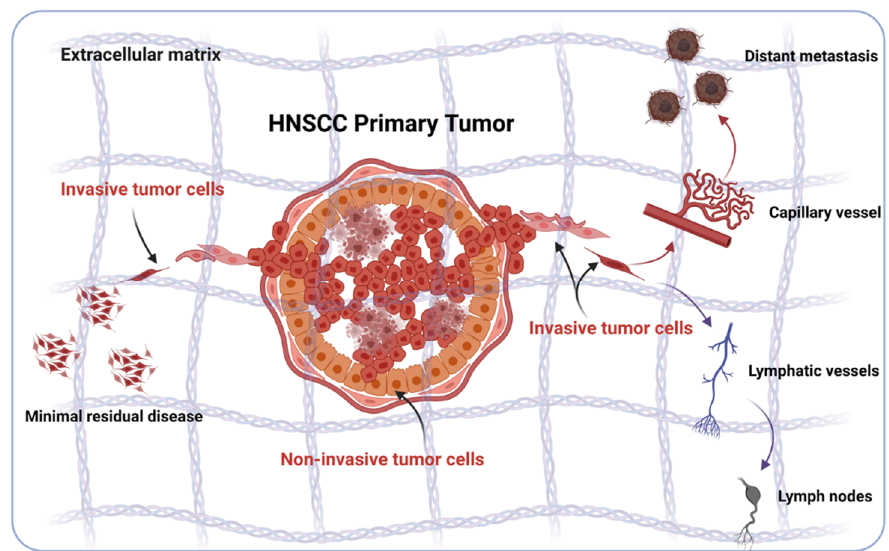
Figure 1. Schematic representation of the involvement of EMT in local, loco-regional, and distant invasion in HNSCC. Sub-populations of HNSCC cells in various states of EMT can loosen cell–cell contacts, detach from the primary tumor, and locally invade surrounding tissue. Locally invading tumor cells can remain as a minimal residual disease despite surgery and resist multi-modal therapy. Alternatively, locally disseminated tumor cells can gain access to lymphatic and blood vessels, colonize loco-regional lymph nodes or distant organs and form metastases (Figure generated using BioRender, Toronto, ON, Canada).